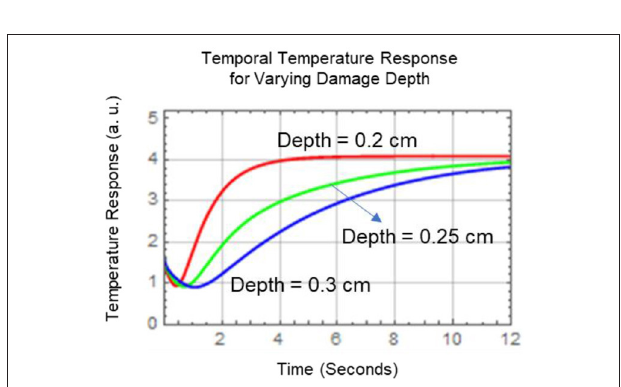
FIGURE 10 | Temporal temperature plots of Equation (6) showing thermal response variation for varying damage